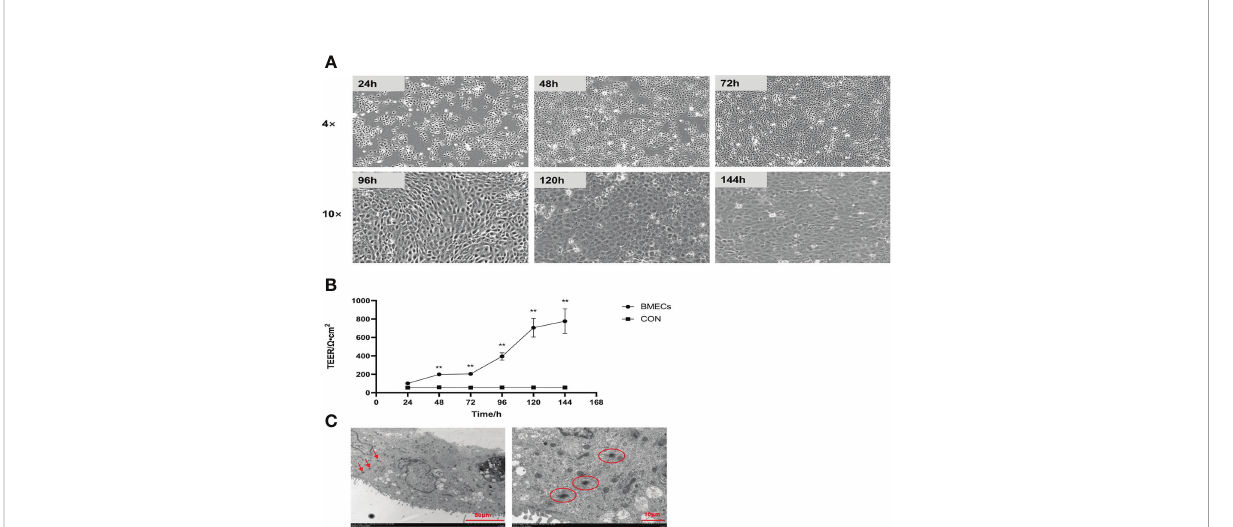
FIGURE 1 Establishment of the monolayer BMEC model (n = 9). (A) Morphology observations of monolayer BMECs using optical microscope; 4× and 10× indicate the magni fi cation of the microscope objective. (B) Effect of culture time on the TEER of monolayer BMECs. **indicates extremely signi fi cant differences between the BMECs and CON group ( P < 0.01), and no marker indicates a non-signi fi cant difference between the BMECs and CON group ( P > 0.05). (C) TEM image of the desmosome structure of monolayer BMECs. TEER means transepithelial electrical resistance. The red arrow and the circled part indicate the desmosome structure. BMECs indicates bovine mammary epithelial cells.